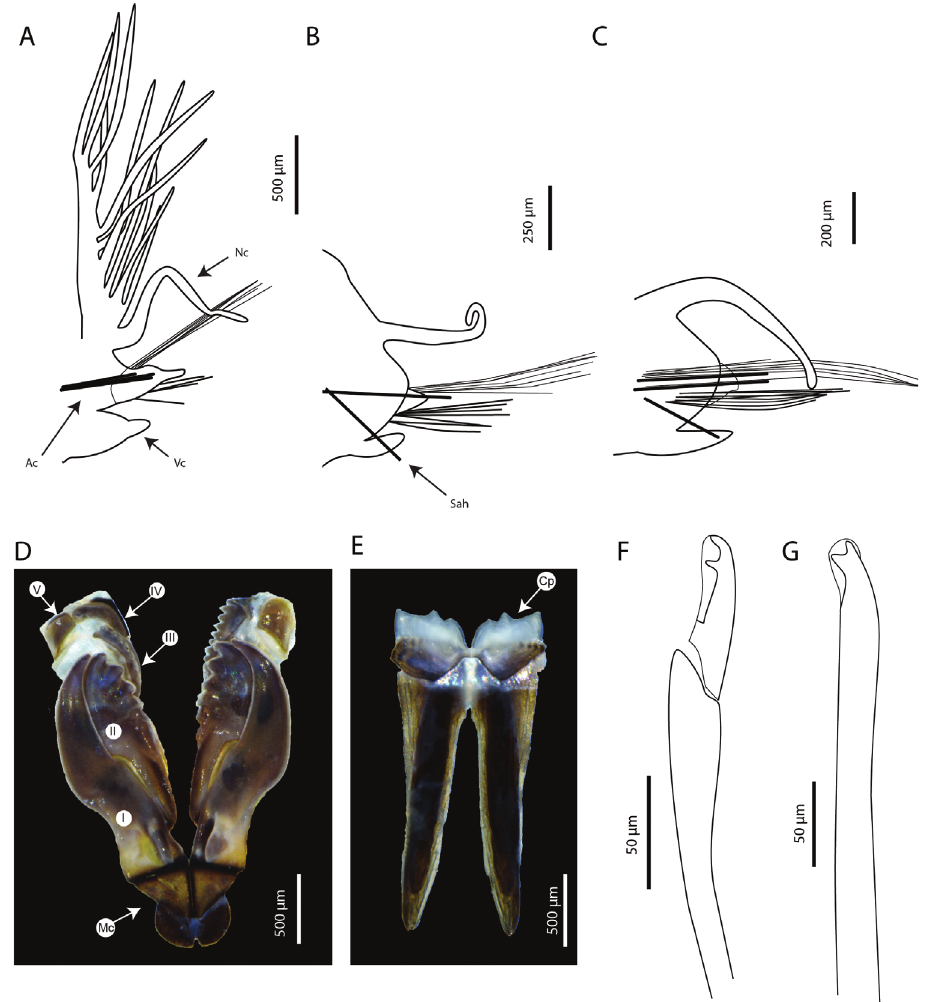
Figure 6. Marphysa papuaensis sp. nov. paratypes MNHN-IA-2015-1415 ( A–C, F, G ), MNHN- IA-2015-1593 ( D, E ): A parapodia from anterior chaetiger (chaetiger 12) B parapodia from mid-body (chaetiger 36) C parapodia from posterior chaetiger (chaetiger 74) D maxilla, dorsal view E mandibles, dorsal view F compound falcigers from anterior chaetiger (chaetiger 12) G subacicular hook from mid- body (chaetiger 36). Abbreviations: MI to MV, maxillae I to V; Ac, aciculae; Cp, cutting plate; Mc, maxil- lary carrier; Nc, notopodial cirri; Sah, subacicular hook; Vc, ventral cirri. A–C Sah and Ac are illustrated schematically to indicate